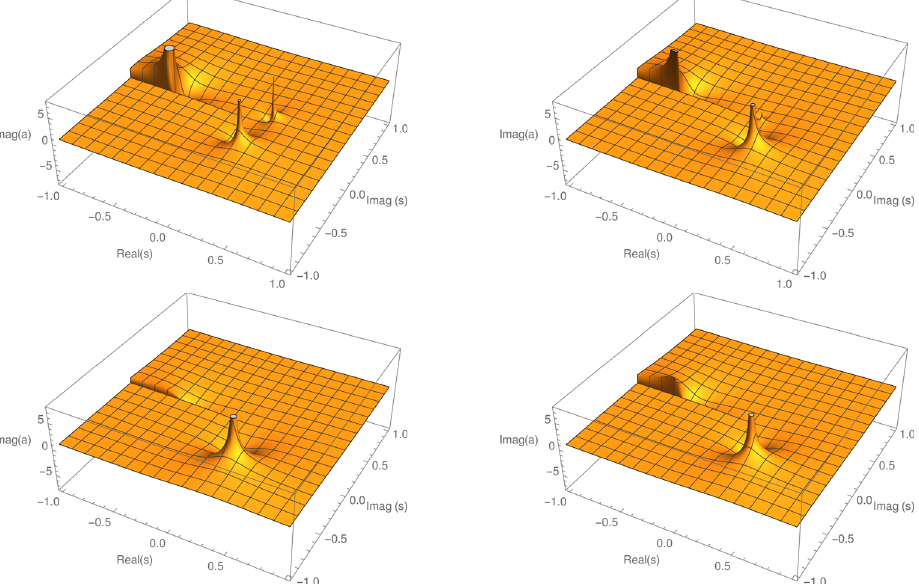
for μ/ M P = 0 . 40 , 0 . 35 , 0 . 30 , 0 . 20. Notice the 0